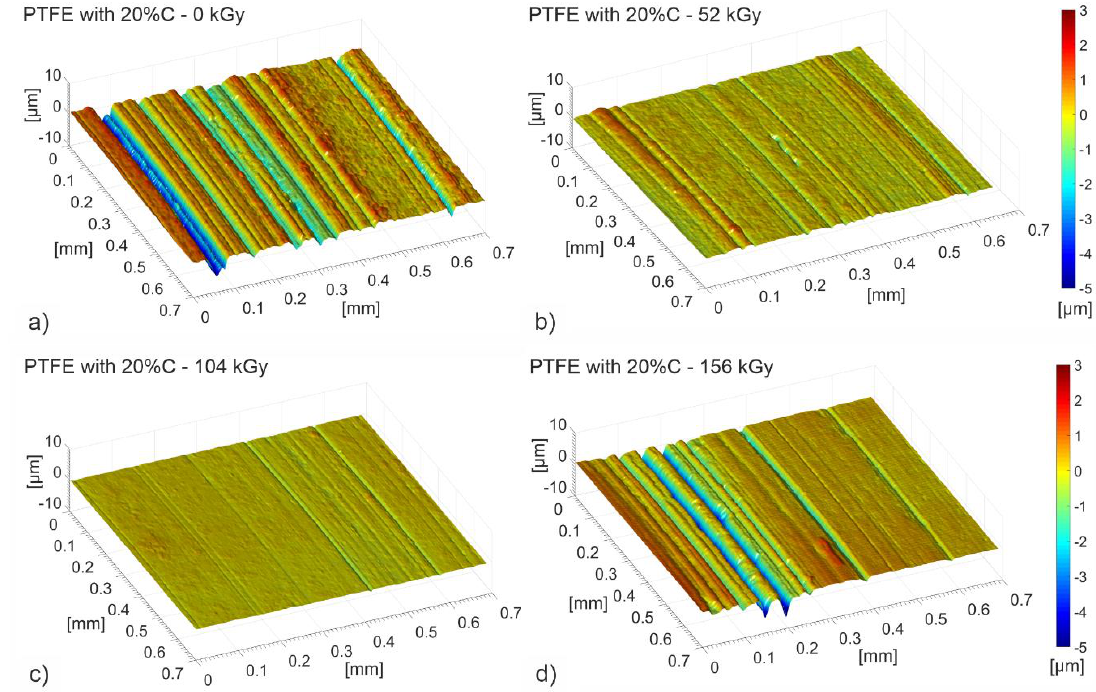
Figure 11. Stereometric structure of the friction surface of PTFE with a 20% graphite addition in its initial state 0 kGy ( a ) and after absorbing a dose of 52 kGy ( b ), 104 kGy ( c ), 156 kGy ( d ).